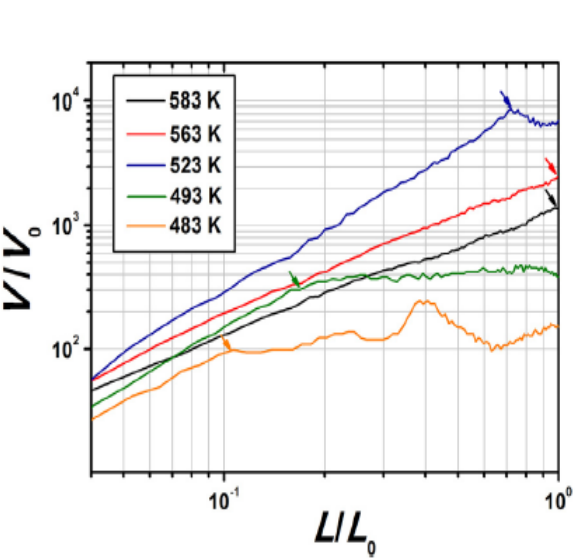
Figure 5. Experimental jet velocity versus spin line for several melt temperatures [26].